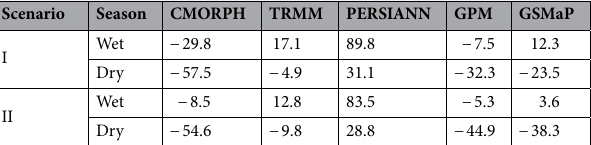
Table 4. Relative Error statistics of simulated streamflow in YZRB in wet and dry